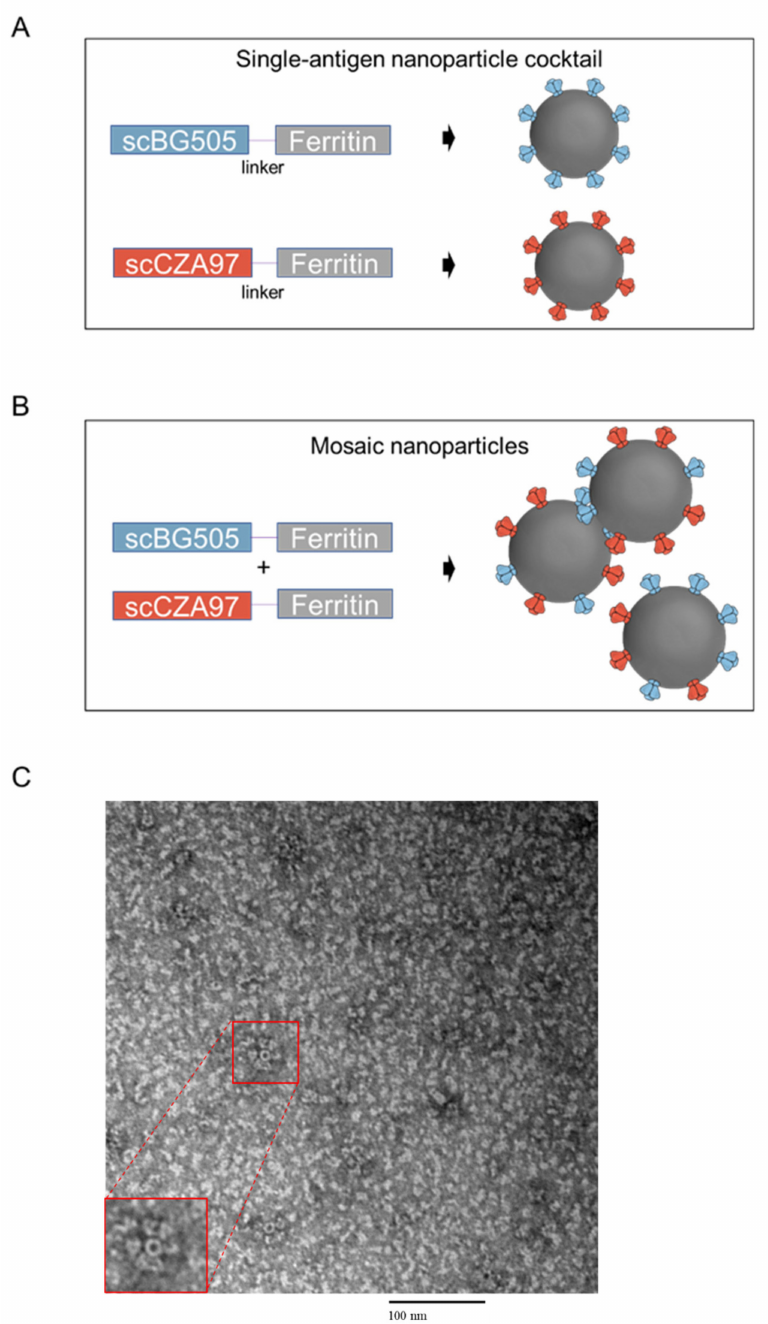
Figure 1. Nanoparticle immunogens. Schematic depicting the ( A ). Single—antigen nanoparticle immunogens and ( B ). Mosaic nanoparticles. Blue and red bars depict the single—chain protomer of envelope proteins from BG505 and CZA97, respectively. The grey bar is representative of one protomer of ferritin. ( C ). Representative electron microscopy (EM) image showing nanoparticle